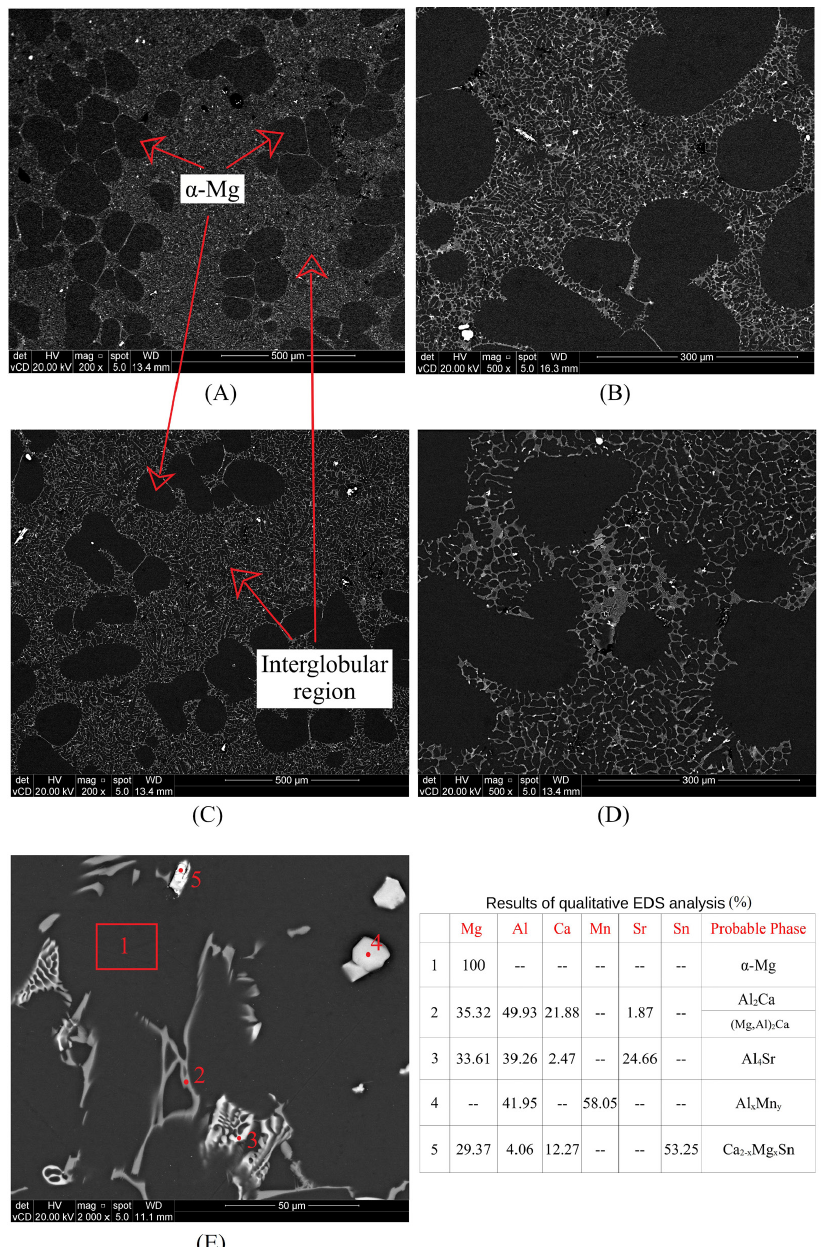
Figure 6. SEM micrographs comparing the processed samples with 6 and 12 mm diameter stirred for 2 minutes in different magnifications. (A) and (B) 6 mm; (C) and (D) 12 mm; (E) EDS